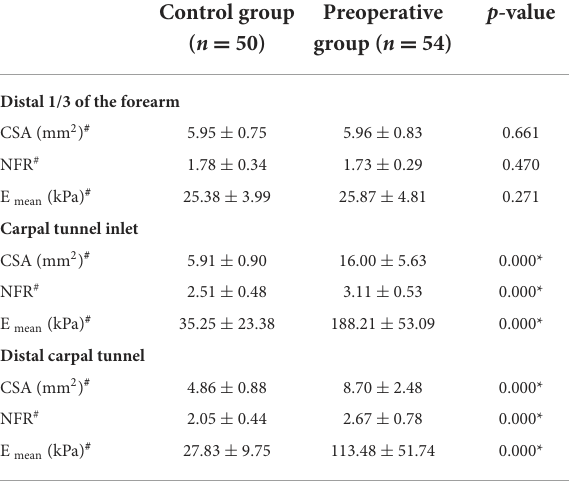
TABLE 2 Conventional ultrasound and shear wave elastography parameters of the control group and the preoperative